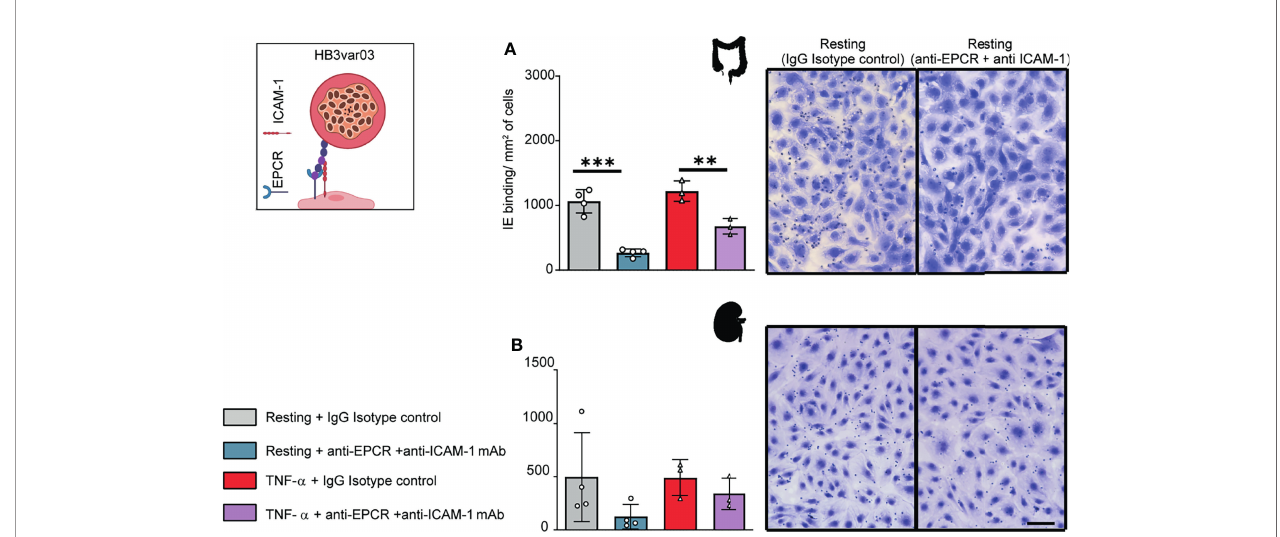
FIGURE 3 | Binding of the HB3var03 parasite line to HIMEC and HKMEC. The HB3var03 parasite was previously selected on brain endothelial cells in vitro and expresses a Group A-PfEMP1 protein that interacts with EPCR and ICAM-1 (cartoon). (A) Binding of HB3var03-IEs to resting and TNF a -stimulated HIMEC cells in the presence or absence of combined anti-EPCR and anti-ICAM-1 antibodies (B) Binding of HB3var03-IEs to resting and TNF- a -stimulated HKMEC cells in the presence or absence of combined anti-EPCR and anti-ICAM-1 antibodies. Data are expressed as mean ± SD and were analyzed by unpaired t test. **p<0.01; ***p<0.001. EPCR: endothelial protein C receptor. Scale bar: 50 µm. Additional data is shown in Supplementary Figure 4